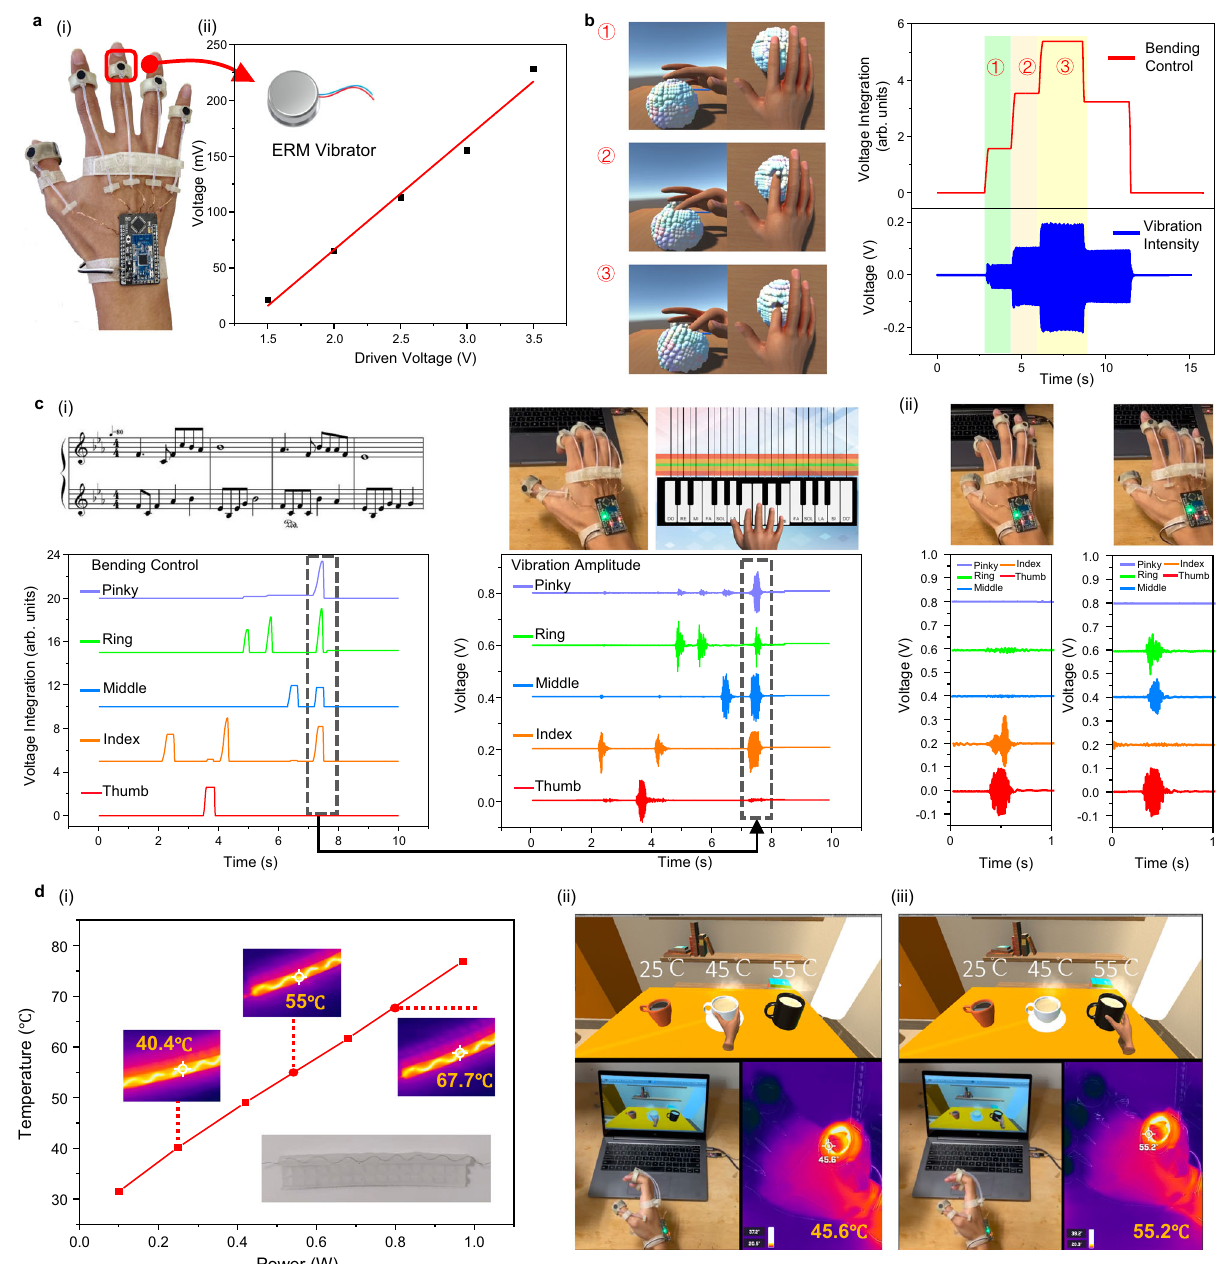
Fig. 4 | Augmented multimodal haptic feedback system compatible with IoT platform. a (i) Illustration of the ATH-Ring based HMI with embedded ERM vibrators. (ii) The relationship between the vibration intensity collected by a PZT vibrationsensorandthedrivenvoltageofthevibrator.Demonstrationofthevibro- hapticfeedbackfunctionvia b squeezingasoftballwithone fi ngerand c playinga